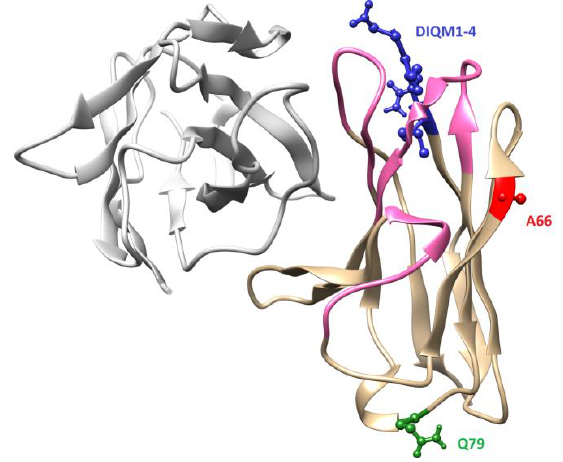
Figure 2. Three-dimensional structure model of the variable fragment (Fv) of BaxM159. The model was generated using the automated antibody modeling web-portal Kotai Antibody Builder (http://kotaiab.org/; [26]). Molecular graphics and analyses were performed with Vector NTI package. HC is gray, LC is beige, CDRs are pink colored. Amino acids DIQM1-4 are blue, A66 is red, Q79 is green colored.